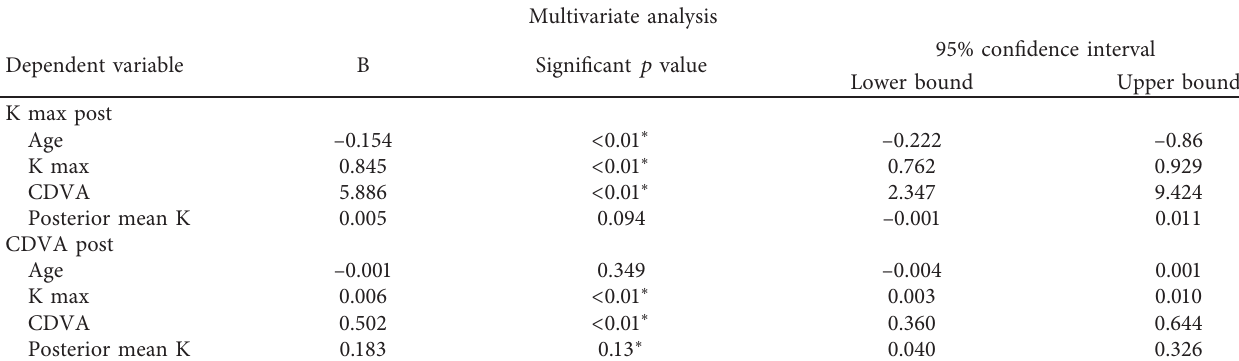
Table 5: Multivariate linear regression of the baseline predictive factors and its impact on the treatment outcomes. Multivariate analysis